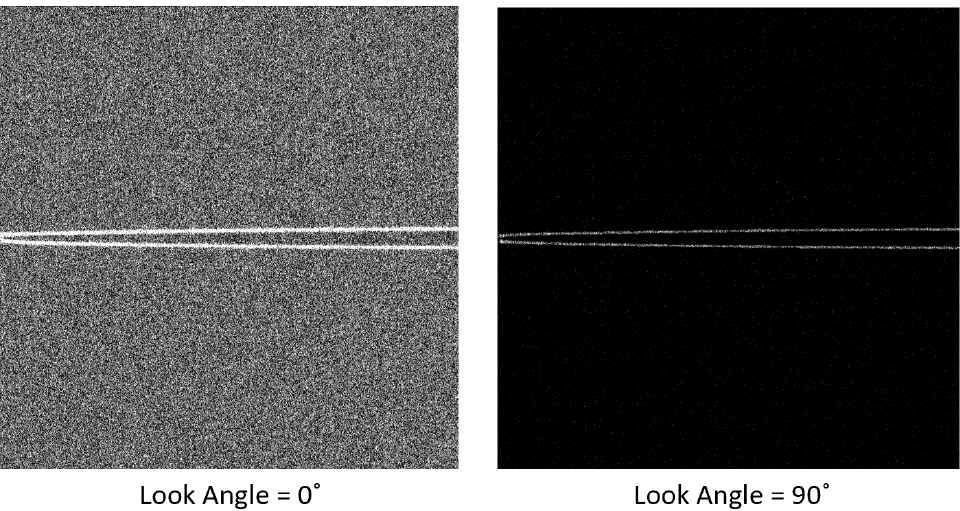
Figure 8. Comparison of the same wake event in the X-Band. On the left is the wake with a look angle of 0 ◦ , and on the right is the wake with a look angle of 90 ◦ . All other generation parameters are the same for these images. The noise level in the background ocean surface in the left is typical of 0 ◦ and 180 ◦ look angles, while the one on the right is typical of look angles of 90 ◦ and 270 ◦